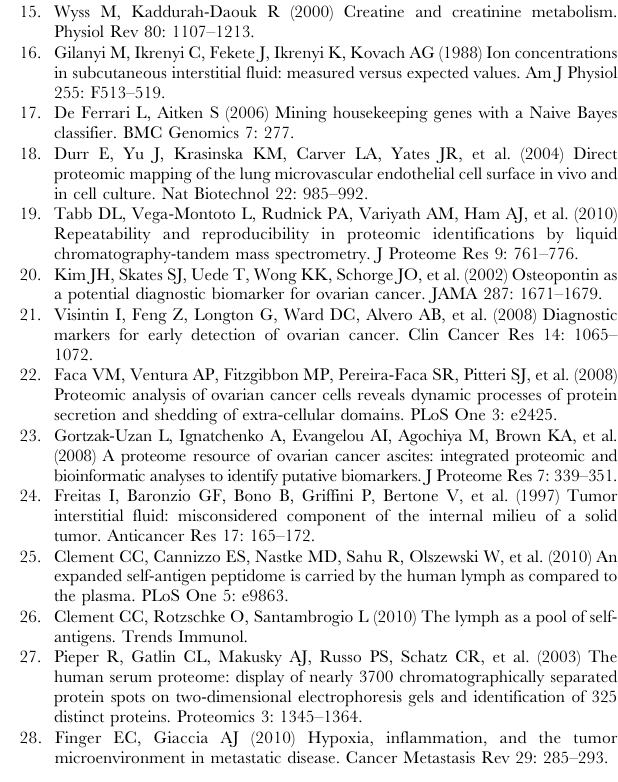
Table S1 Intracellular proteins. Number of spectra identi- fied for albumin and 15 selected intracellular proteins. (PDF) Table S2 Information on identified proteins. Summary of identified proteins, with detailed information, in tumor fluid, patient plasma and control plasma with a Spectrum Mill score higher than 13 and at least two peptides.